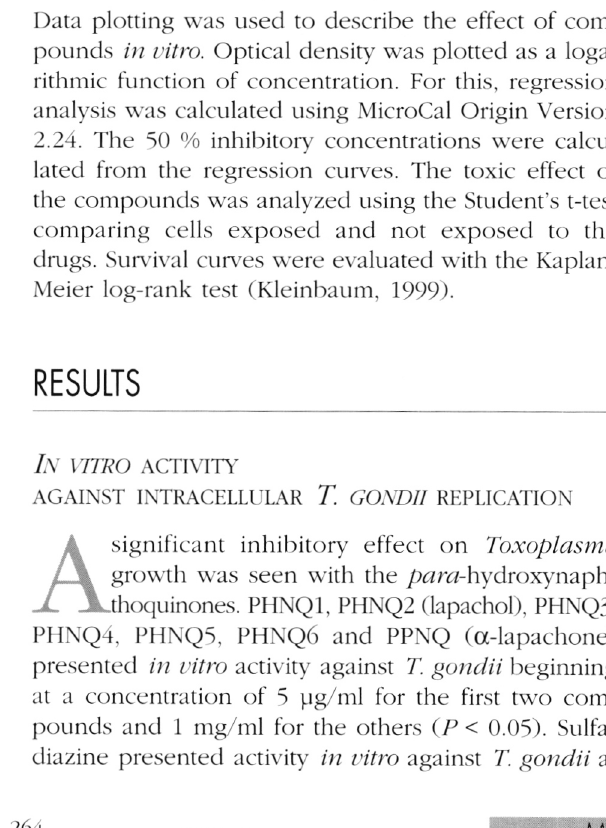
concentration of 5 pg/ml (Fig. 2). These results were confirmed in a second experiment (data not shown). From the regression curve analysis, IC50 % was 25,45